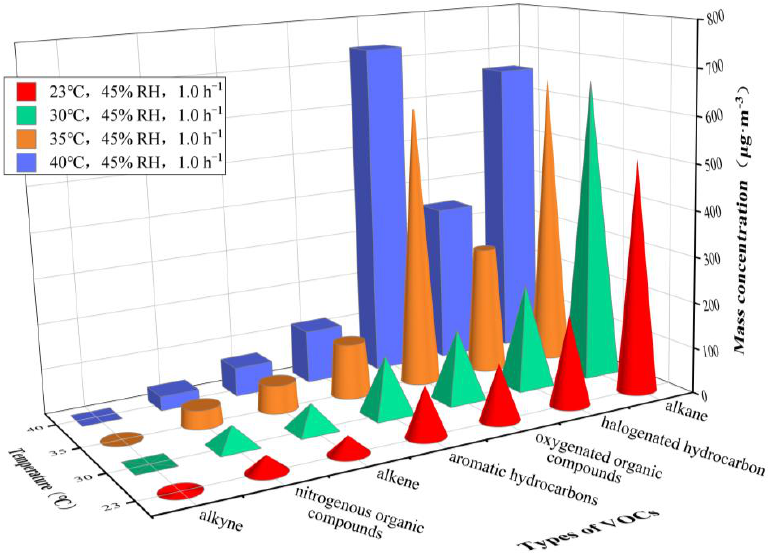
Figure 4. Mass concentrations of VOCs released from plastic track at temperatures varying from 23 to 40°C. RH = 45% and AER = 1.0 h −1 . Table 2. Mass concentrations of main VOCs released from plastic track under different environmental